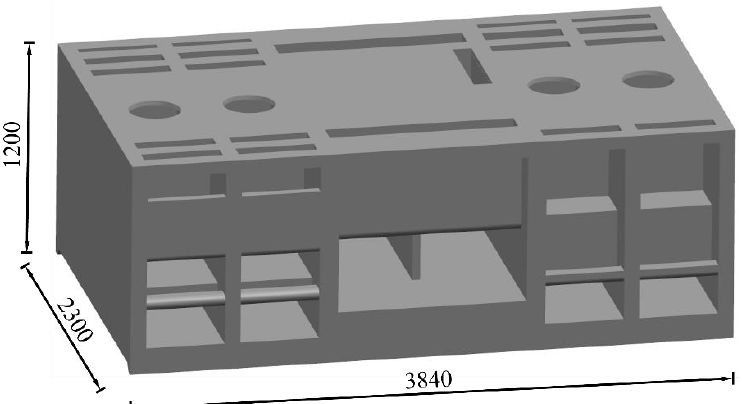
Figure 1. Geometric model of station building.